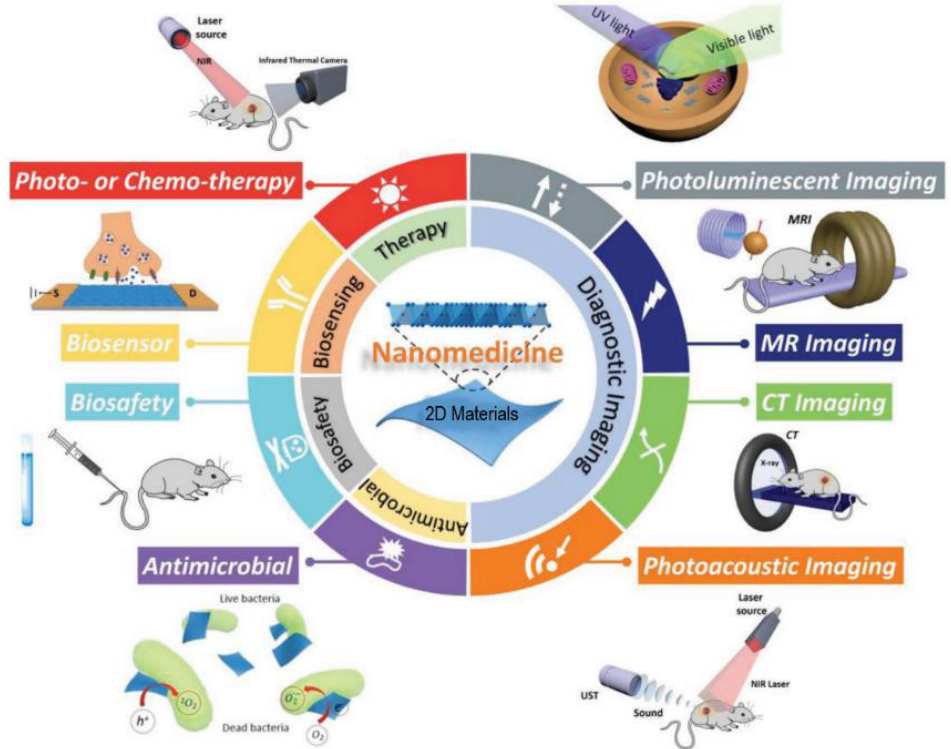
Figure 2. Overview of the biomedical applications of two-dimensional nanomaterials (2DnMat). 2DnMat can be used, for example, for photothermal therapy induced by near infrared (NIR) radiation; photodynamic therapy (PDT), combining light irradiation with photosensitizer drugs; for diagnostic imaging, such as photoluminescent, photoacoustic, magnetic resonance (MR) or computed tomography (CT) imaging; for antimicrobial effect through direct membrane damages or production of reactive oxygen species (ROS). Additionally,2D nanomaterials can be designed to present low cytotoxicity and adequate biosafety. They can also be used to develop innovative biosensors. Adapted from [33] © 2018 The Authors. Published by WILEY-VCH Verlag GmbH & Co. KGaA, Weinheim.